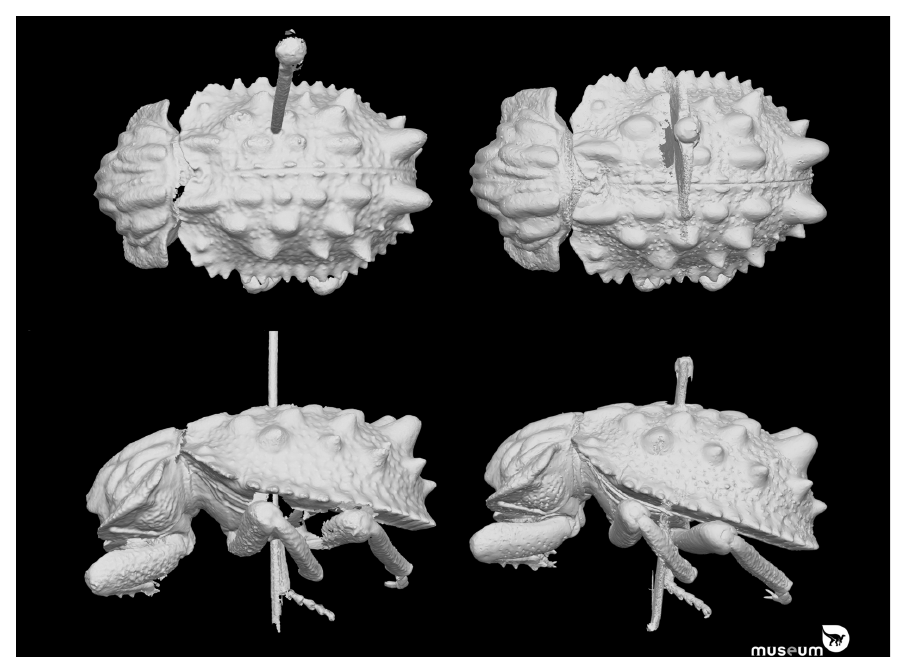
Fig. 6.9. Omorgus beetle structured light scanning with MechScan (left) comparison to µCT scan (right). The main difference is the lack of artefacts due to the needle with the MechScan 3D model. But the MechScan model lacks almost the entire ventral area of the abdomen between the legs.